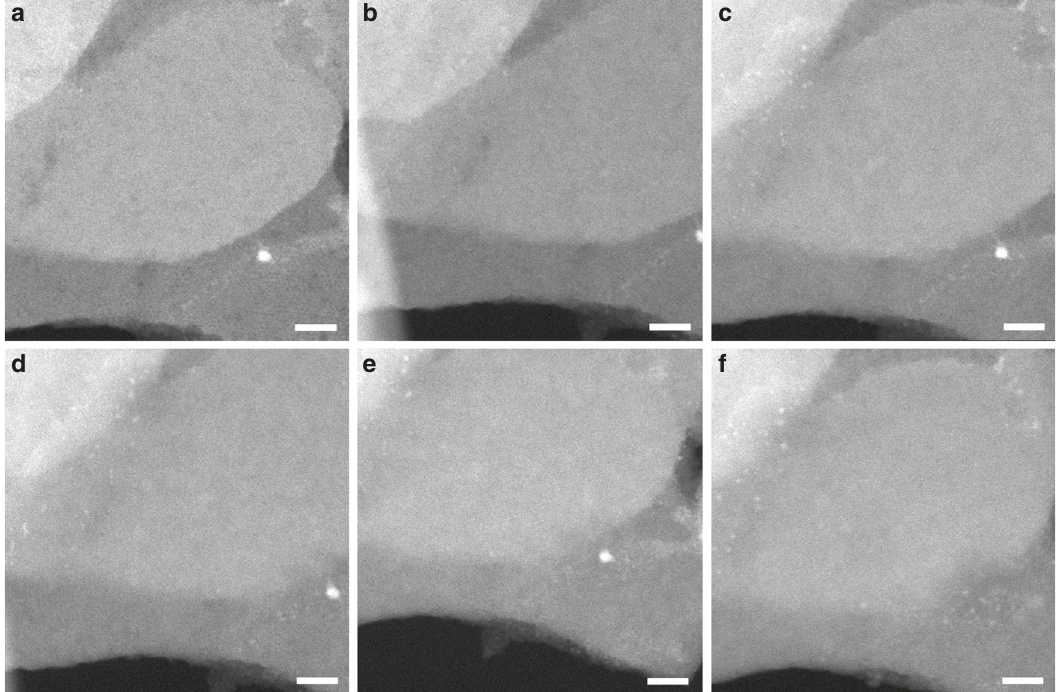
Fig. 3 Structural evolution of 0.17%Pt@MCM-22-300H 2 under CO + O 2 conditions. During the in situ TEM experiments, the sample was treated in mixture of CO (0.2 torr) and O 2 (0.1 torr) for 15 min at different reaction temperature, respectively. In order to avoid the carbon deposition of CO by the electron beam, the TEM chamber was evacuated to remove CO gas after exposure of the sample to CO + O 2 gases. a Room temperature, b 100 °C, c 150 °C, d 200 °C, e 300 °C, f 400 °C. Scale bar in all the images in this fi gure: 10